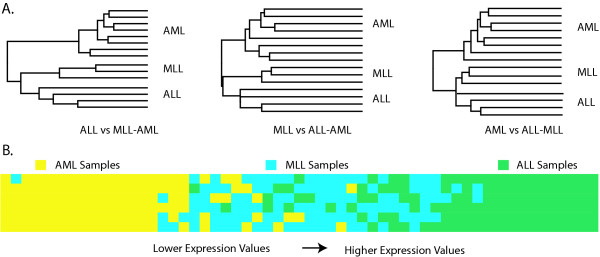
Separation of AML, MLL and ALL leukemia samples into three distinct clusters and supporting genes. A. Note that all three dendrograms assign MLL samples closer to ALL samples. B. Expression profiles of six of the most important genes that support this clustering. As evident from the figure, different expression intervals correspond to the three different classes for all six genes. More information about these genes can be found in Table 5 of [Additional file 1].